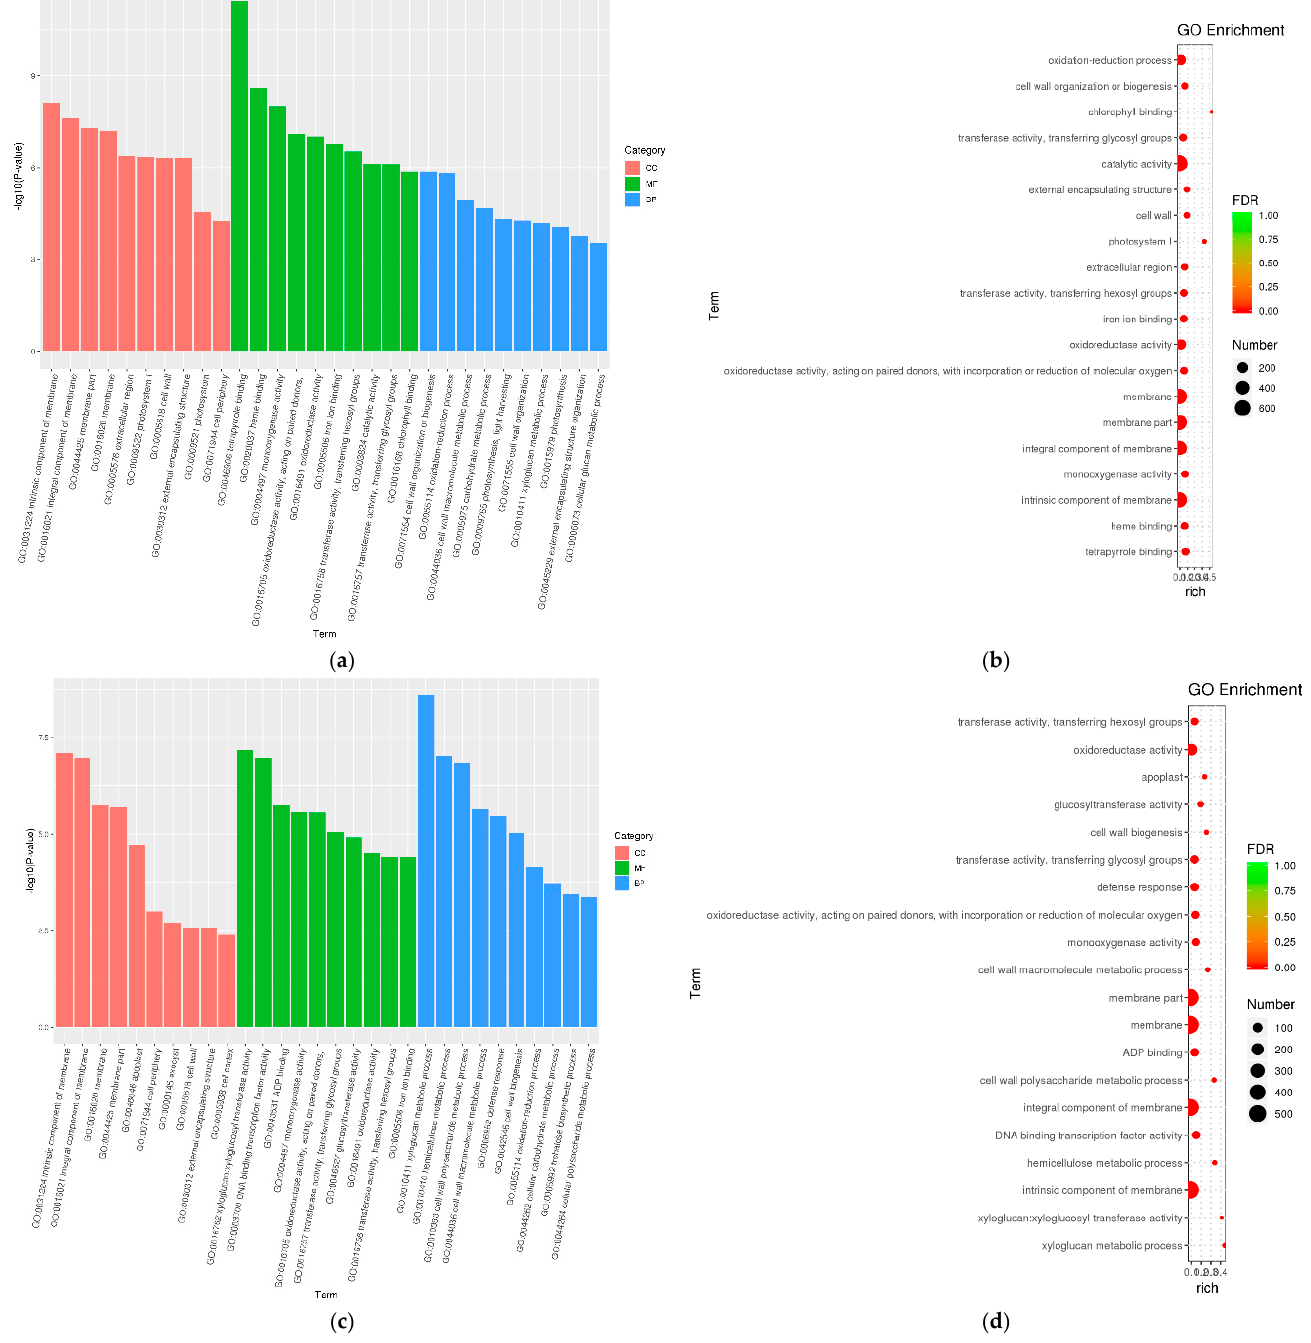
Figure 5. Changes in gene ontology (GO) enrichment analysis in fruits of two late-ripening sweet oranges, Lane Late Navel (LW) ( a , b ) and Rohde Red Valencia (XC) ( c , d ) after foliar spray of easily extractable glomalin-related soil protein (EE-GRSP). Abbreviation: LW_EG, the LW variety sprayed with EE-GRSP; LW_Non_EG, the LW variety not sprayed with EE-GRSP; XC_EG, the XC variety sprayed with EE-GRSP; XC_Non_EG, the XC variety not sprayed with EE-GRSP.